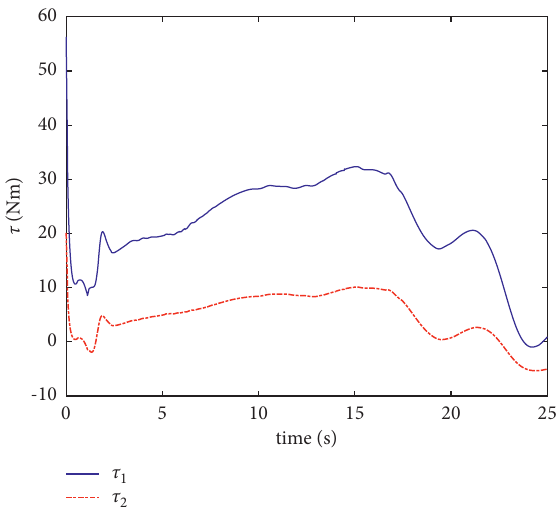
Figure 4: The super-twisting terminal sliding-mode impedance